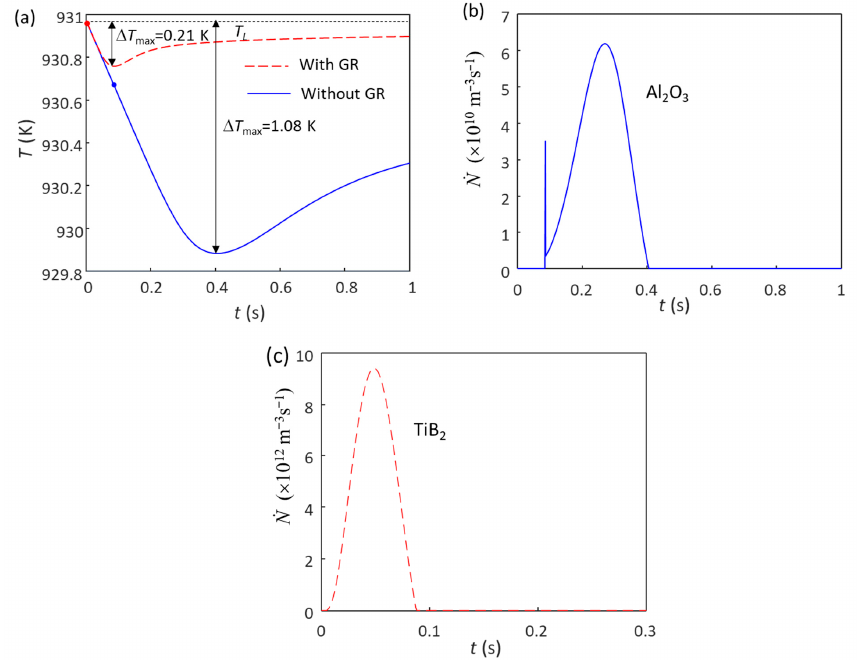
Figure 1. Solidification behavior of Al-1Cu alloy without and with the 1 ppt (0.1 wt.%) addition of Al-5Ti-1B grain refiner (GR) under a cooling rate of 3.5 K/s. ( a ) Cooling curves; ( b ) grain initiation rate without the addition of Al-5Ti-1B grain refiner; ( c ) grain initiation rate with the addition of Al-5Ti-1B grain refiner. The red and blue dots in ( a ) mark the onset of grain initiation on solid particles induced by TiB 2 and Al 2 O 3 particles, respectively.